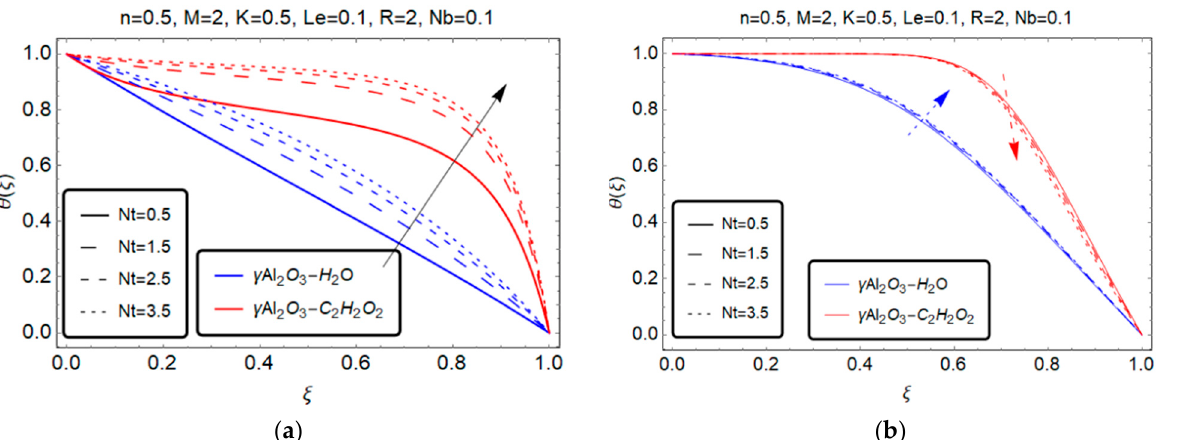
Figure 7. Effect of thermophoresis parameter 𝑁 (cid:3047) on 𝜃(𝜉) . ( a ) S > 0; ( b ) S < 0.